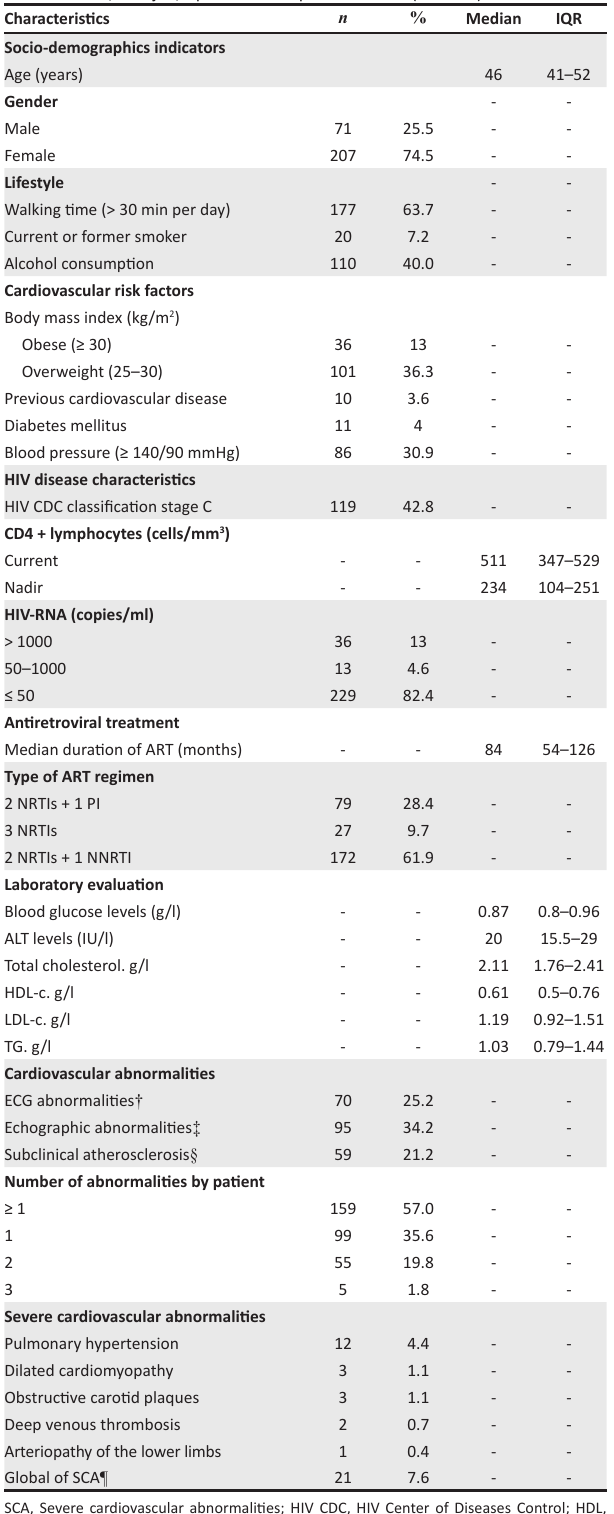
TABLE 1: Baseline characteristics and prevalence of severe cardiovascular abnormalities, Abidjan, April 2015 – September 2015 ( N = 278).